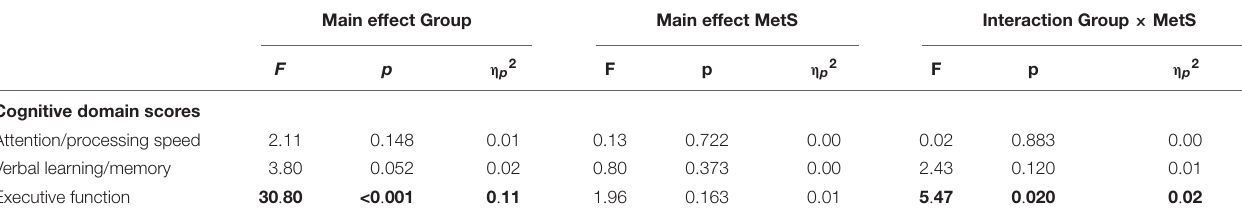
TABLE 3 | Univariate results following two-way